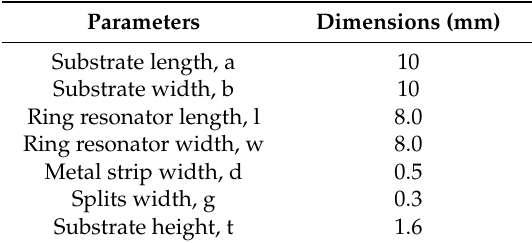
Table 1. Dimensions of the proposed meta-atom unit cell.